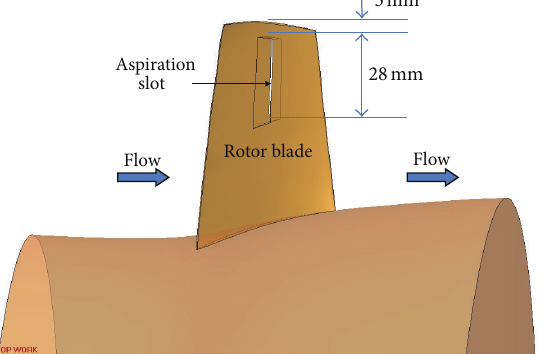
Figure 1: CAD model of NASA 37 transonic compressor rotor.